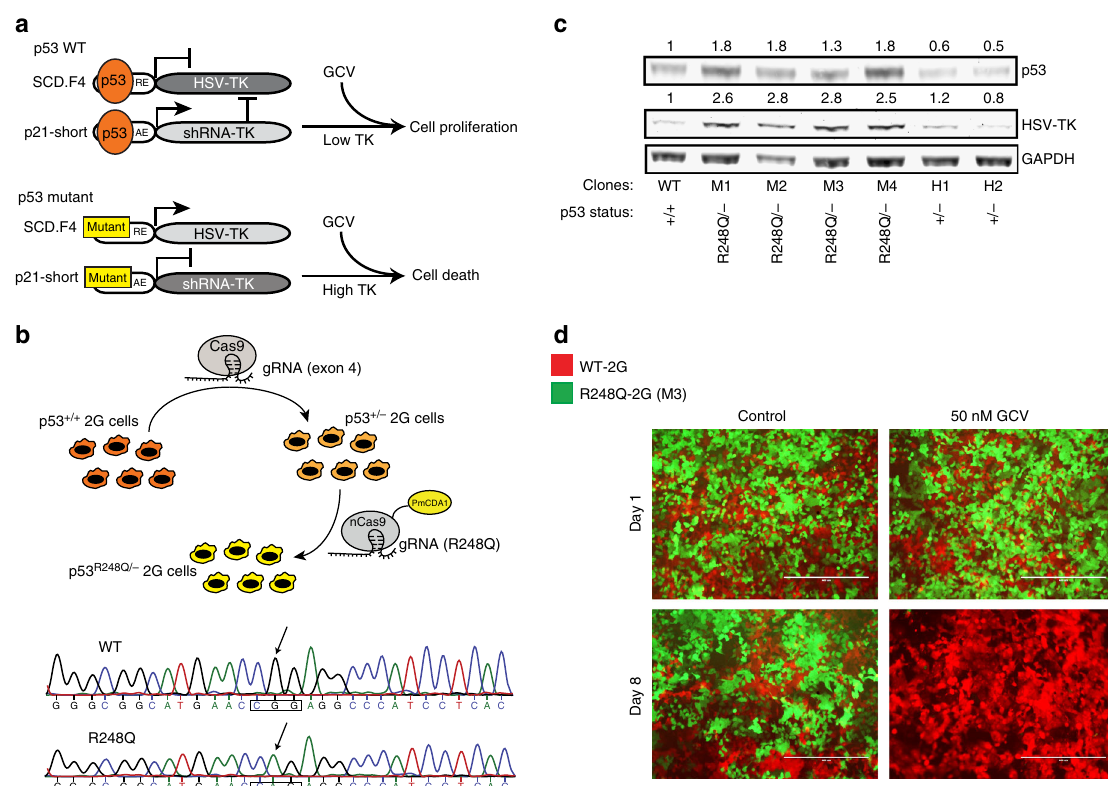
Fig. 3 The sensor can discriminate between WT and a hot-spot mutant of p53. a Schematic representation of the effect of WT and mutant p53 on the sensor. b Top; illustration for generating hemizygous (p53 R248Q/ − ) cells. Employed Cas9-proteins and the utilized gRNAs are shown. Bottom; electropherogram con fi rming the R248Q mutation in hemizygous (p53 R248Q/ − ) cells. c Western blot depicting upregulation of HSV-TK in four different clones harboring the R248Q mutation. The relative quanti fi cation to GAPDH of HSV-TK and p53 band signals is shown. d Representative images of the two-color assay in which a mix of WT-2G (m-Cherry-tagged) and R248Q-2G mutant cells (M3 clone; GFP-tagged) was either treated with 50 nM GCV or control (water) for indicated period of time. Scale bars represent 400 μ suf fi cient to signi fi cantly suppress luciferase expression (Supple-